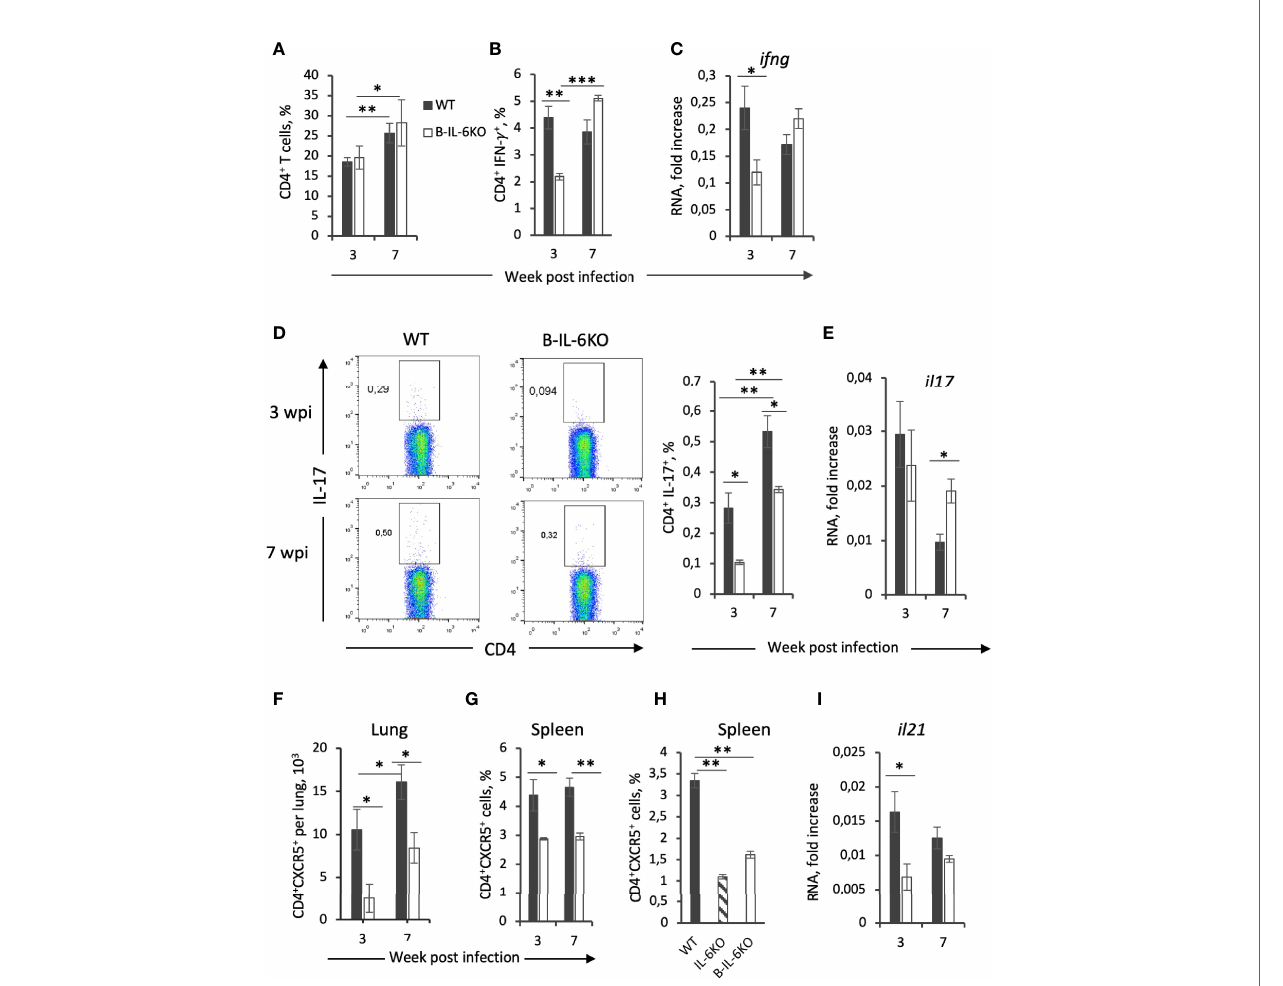
FIGURE 2 | Characteristics of T-cell responses of M. tuberculosis -speci fi c CD4 + T cells from B-IL-6KO and WT mice. (A) Frequency (%) of total CD4 + T cell population in the lung of IL-6B and WT mice, revealed by fl ow cytometry in 3 and 7 weeks post-infection. (B, D) Single cell lung suspensions were cultivated overnight in the presence or absence (control) of mycobacterial antigens and subsequent intracellular cytokines IFN- g (B) and IL-17 (D) produced by CD4 + T cells were evaluated by fl ow cytometry. (C, E, I) qPCR analysis of ifng , il17 , and il21 mRNAs in lungs at week 3 and 7 post infection. Expression of each gene was normalized to hprt . (F – H) The amount of CD4 + CXCR5 + Tfh cells in lungs (F) and frequency within CD4 + population in spleens of infected (G) and non-infected (H) B-IL-6KO and WT animals were assessed by fl ow cytometry. Results are expressed as mean ± SD, 4-5 mice per group per time-point. The results from one of two similar experiments are displayed. * P < 0.05; ** P < 0.01; **** P <